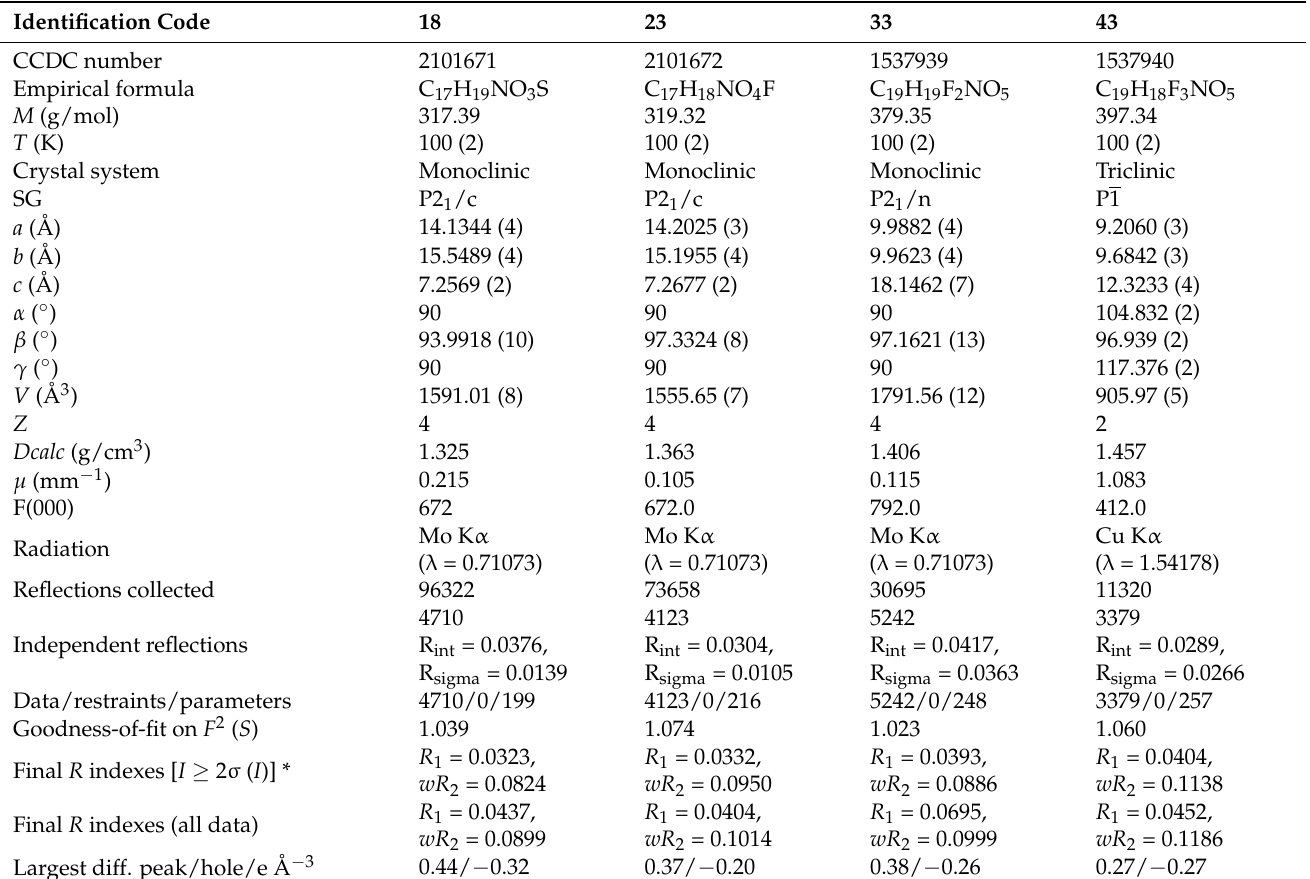
Table 3. Crystal data and structure refinement details for imines 18 and 23 , 3-fluoro β -lactam 33 and 3,3-difluoro β -lactam 43 .